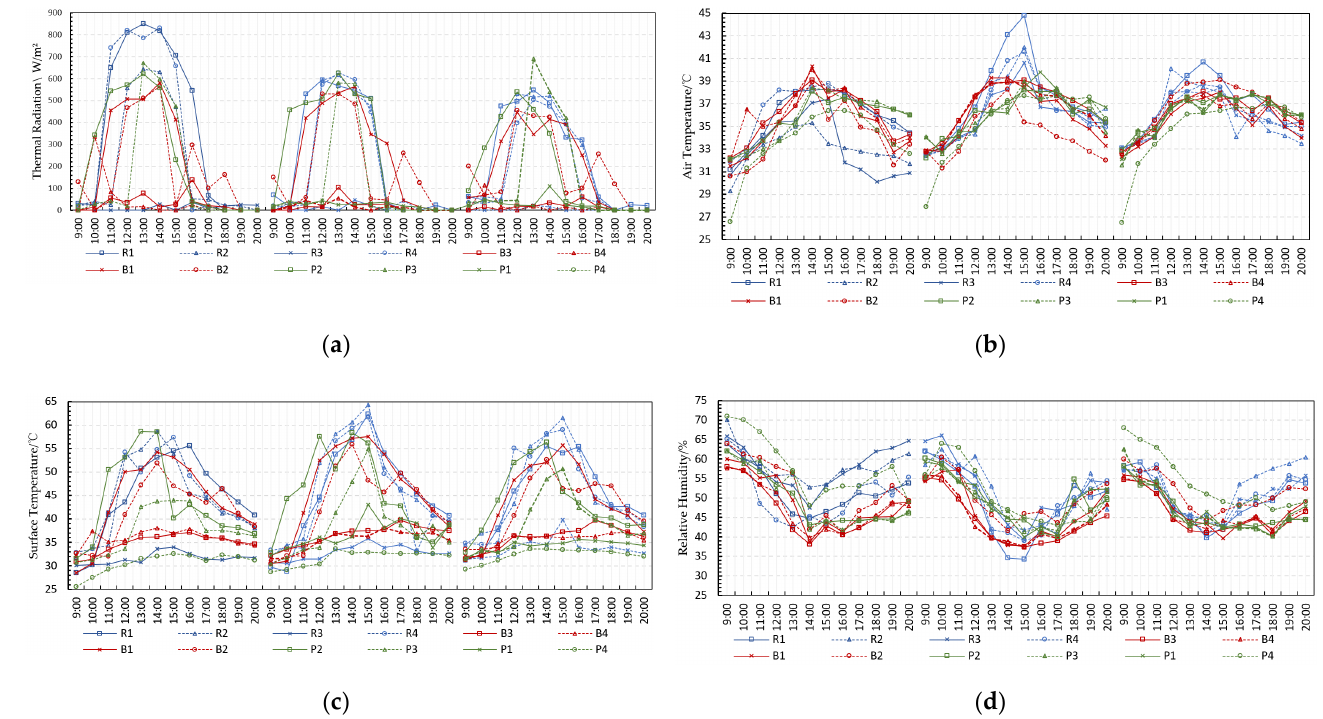
Figure 5. Folding line diagram of thermal environment factors for each measurement point: ( a ) Ther- mal Radiation; ( b ) Air Temperature; ( c ) Surface Temperature; ( d ) Relative Humidity. ( a ) Thermal Radiation; ( b ) Air Temperature; ( c ) Surface Temperature; ( d ) Relative